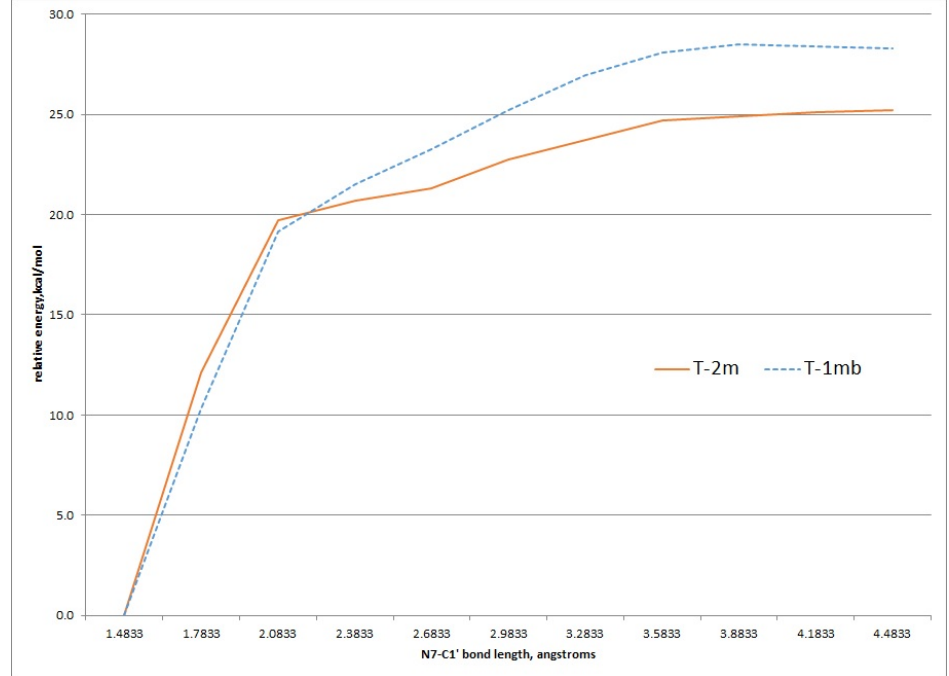
Figure 6. Relaxed potential energy scan of increasing N7-C1' bond length for the T-2m and T-1m tautomers, HF/MIDI! theory (PCM =